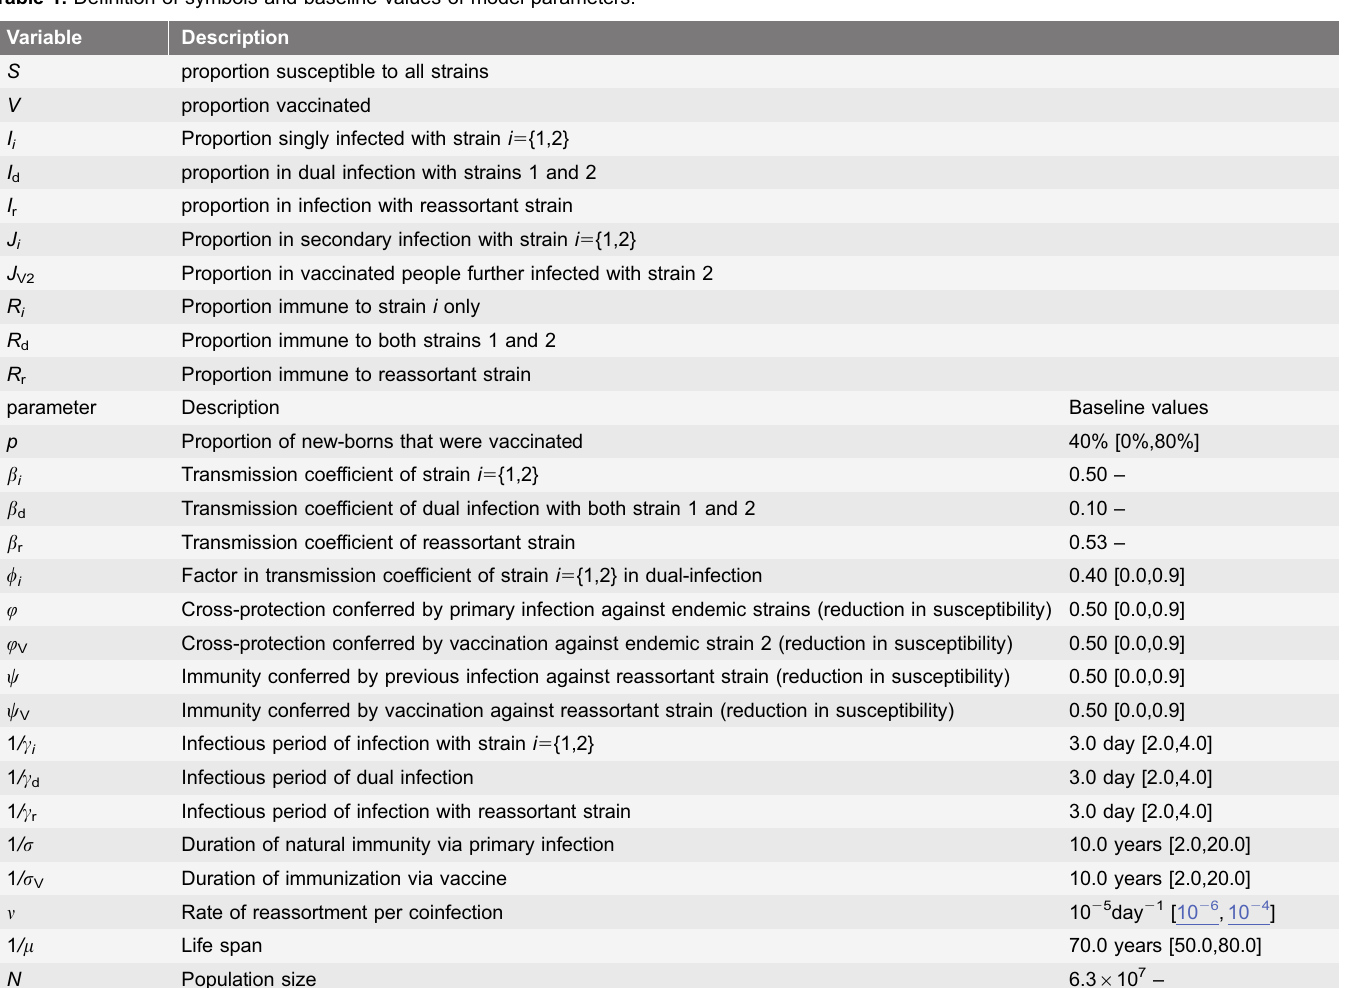
Table 1. Definition of symbols and baseline values of model